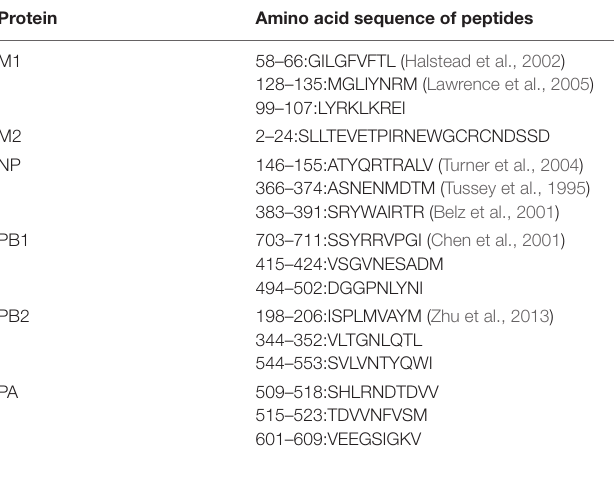
TABLE 1 | Influenza A virus-specific peptides employed to stimulate splenocytes for the quantification of T cell